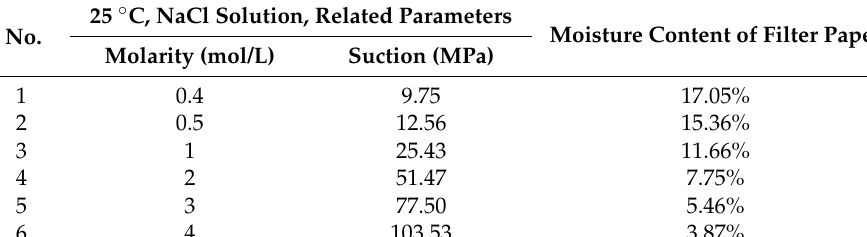
Table 3. Results of suction calibration test for “Whatman No. 42” filter paper.